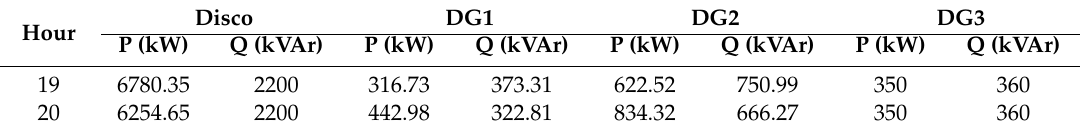
Table 6. Optimal active/reactive power dispatches of generation units at hours 19–20 in Scenario 2.